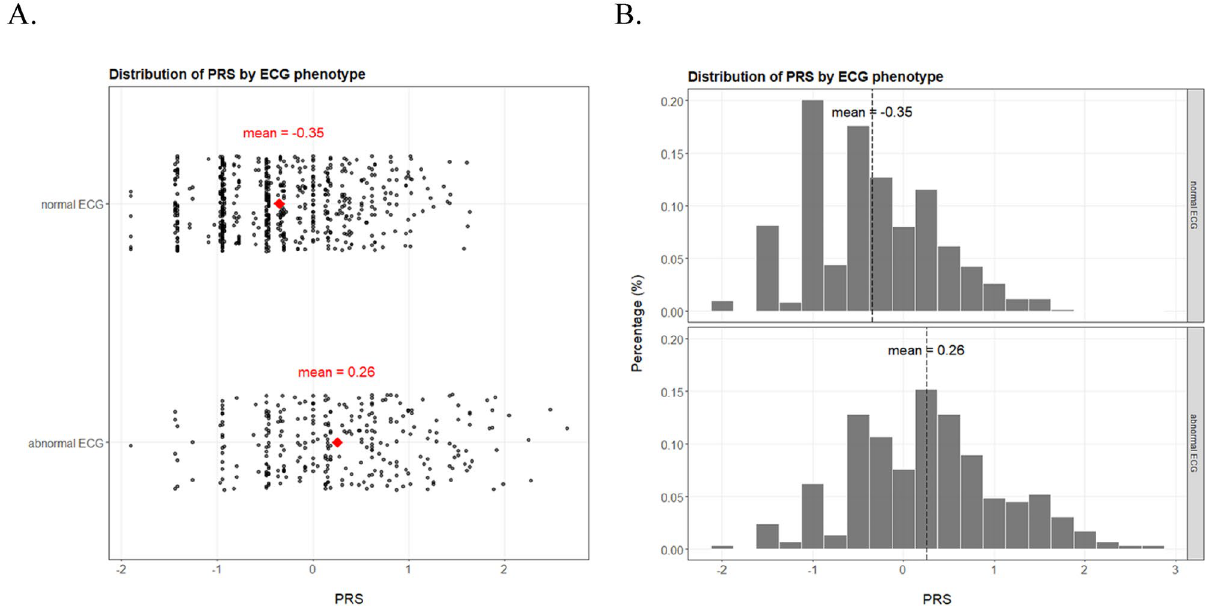
Figure 3. Distribution of PRS by ECG phenotype in the jittered dot plot ( A ) and the histogram ( B